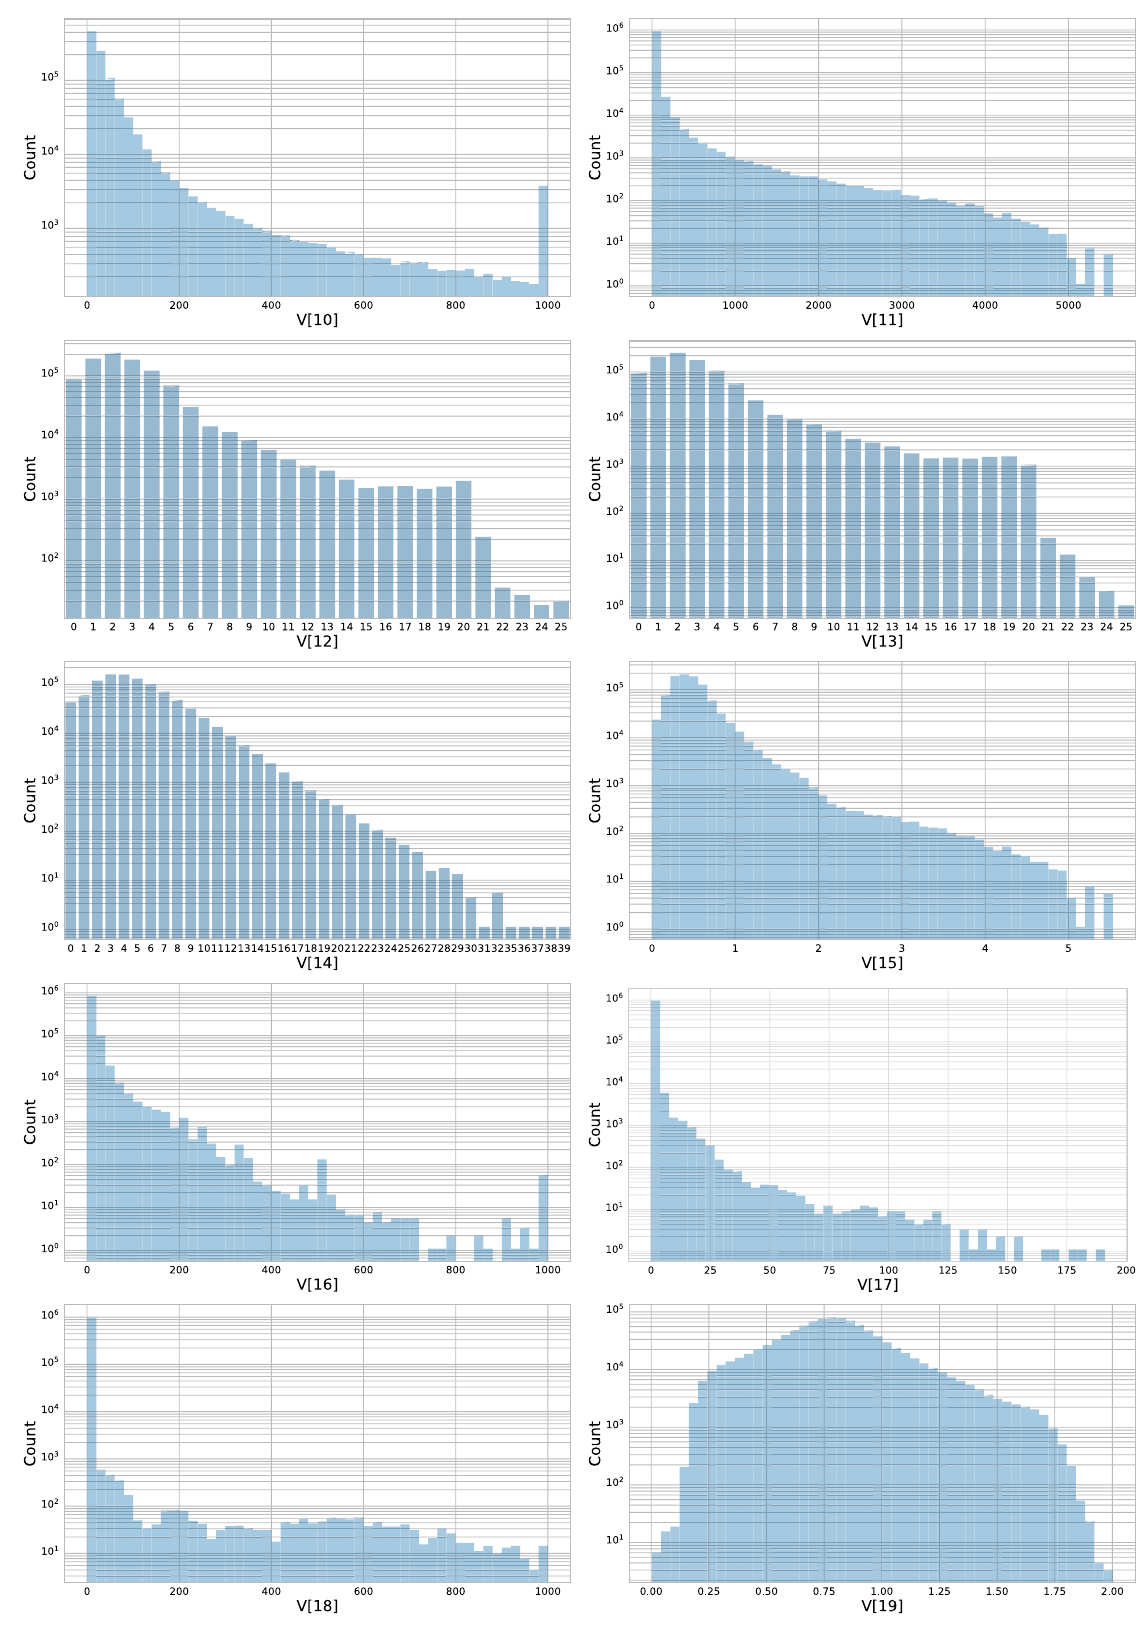
Fig. 16 1D density-distributions of features V[10] to V[19]. Features are defined in Sect.